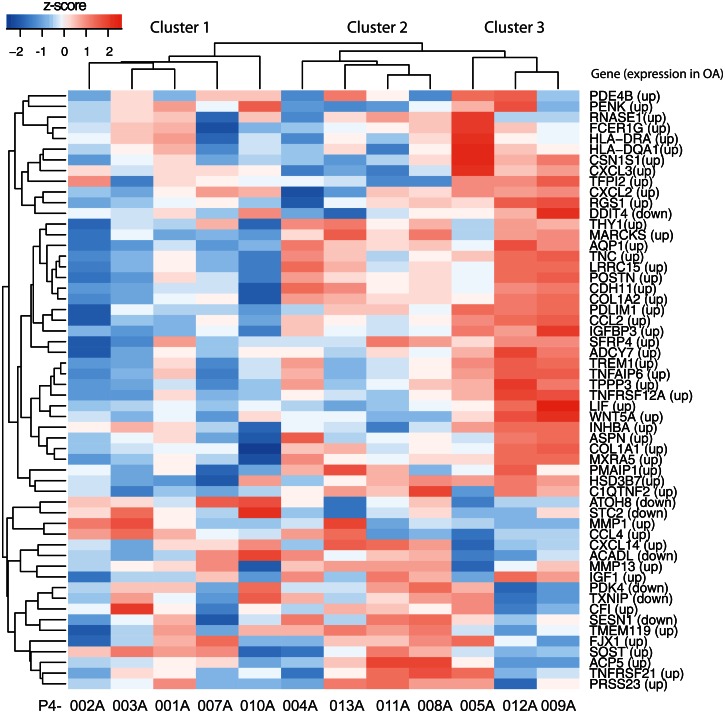
Heat map view of z-scored expression profiles of gene transcripts differentially expressed between healthy and OA cartilage.Hierarchical clustering separated the study patients into three distinct clusters. The list of gene transcripts used for cluster analysis was generated in a prior study by Karlsson et al. [40] that looked at the transcriptome-wide RNA expression of healthy and OA cartilage. This list represented all the expressed gene transcripts differentially expressed between healthy and OA cartilage at >15-fold difference.